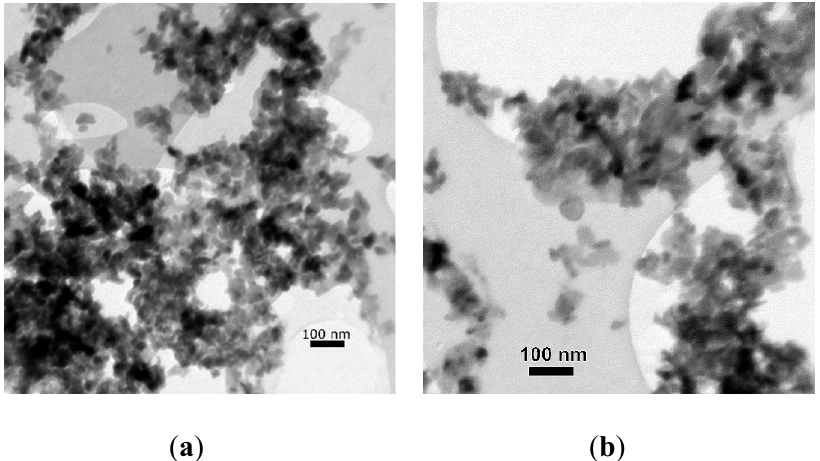
Figure 5. Transmission electron microscopy image of ( a ) Pristine ZnO nanoparticles ( b ) Partially transformed ZnO nanoparticles to Zn oxalate dihydrate.